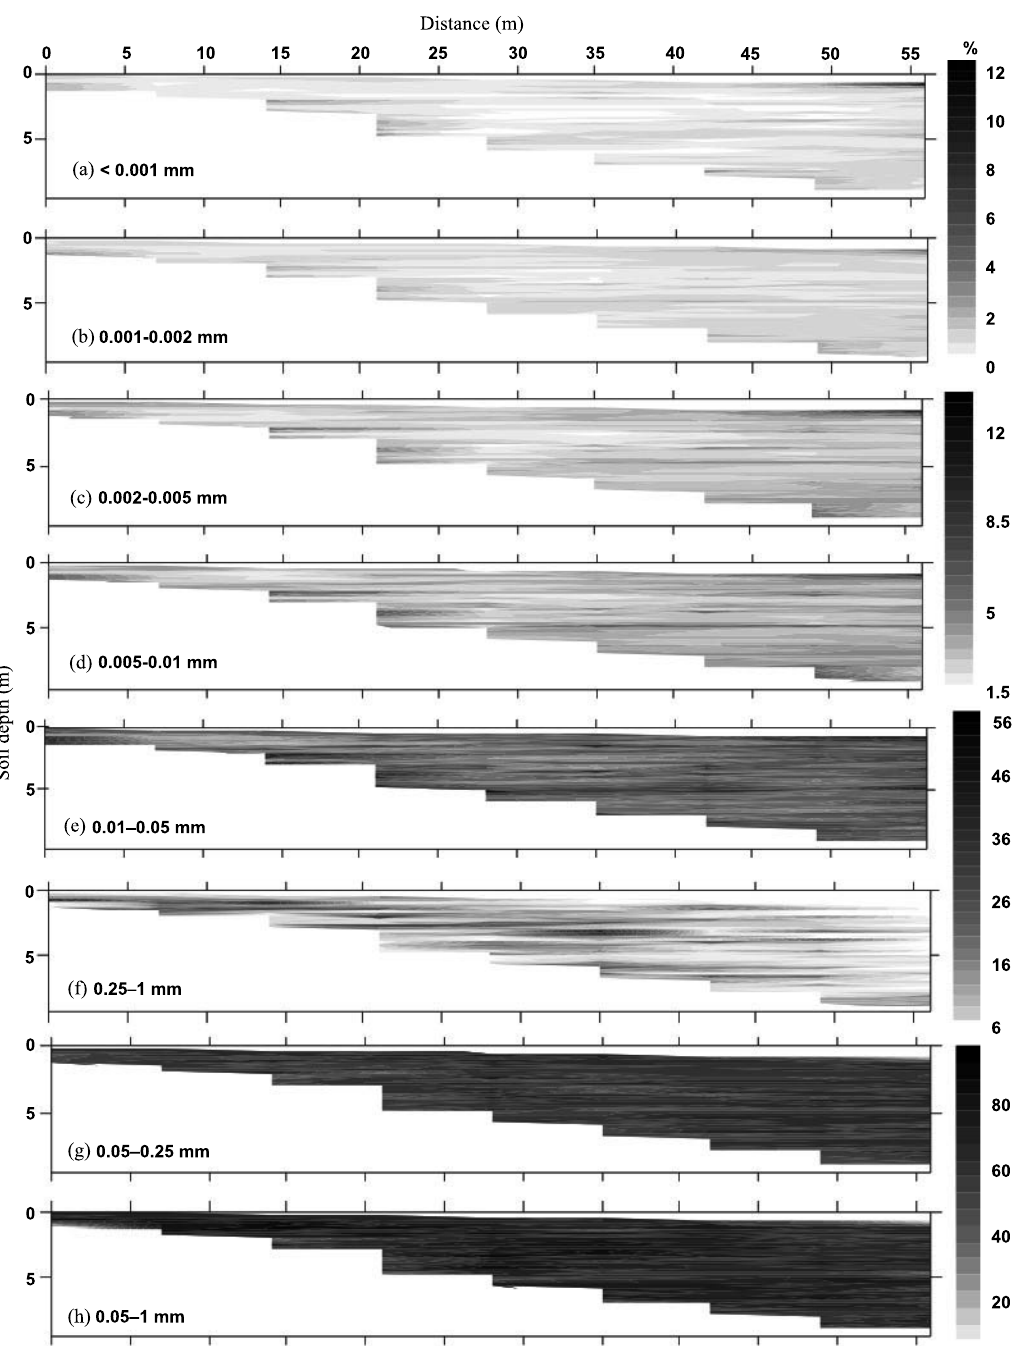
Figure 2. The redistributions of various particle sizes within Chinese taxonomy on the profile of filled deposited farmland soil (the direction of erosion flow is from 0 to